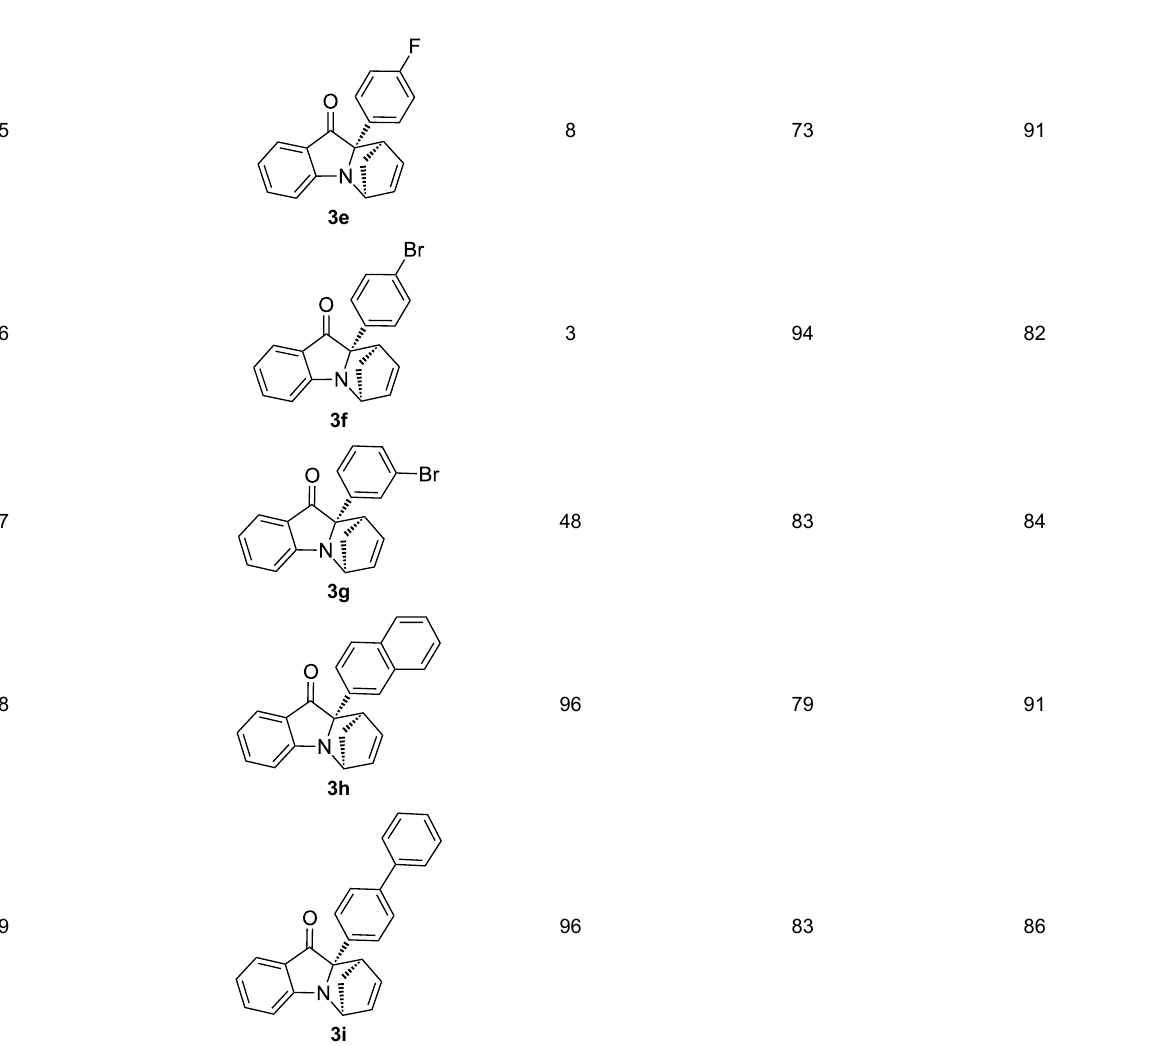
Table 2: Scope of the aza-Diels–Alder reaction a .